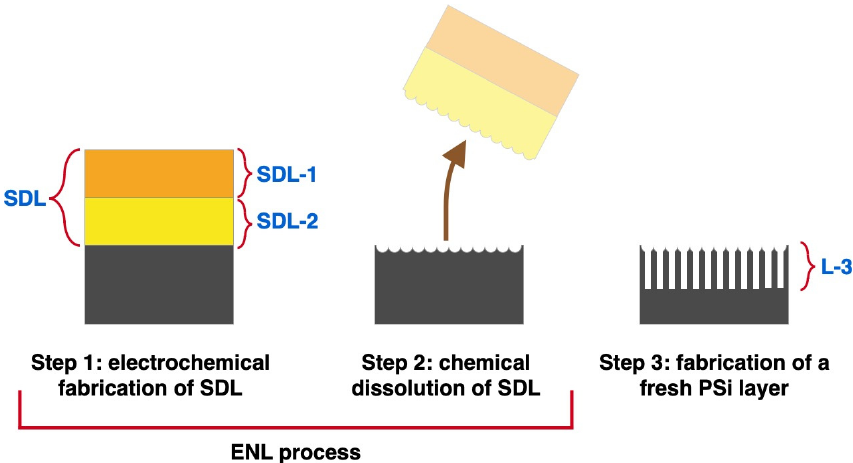
Figure 1. Schematic of the fabrication of a controlled porous layer using the electrochemical nanolithography (ENL) process.